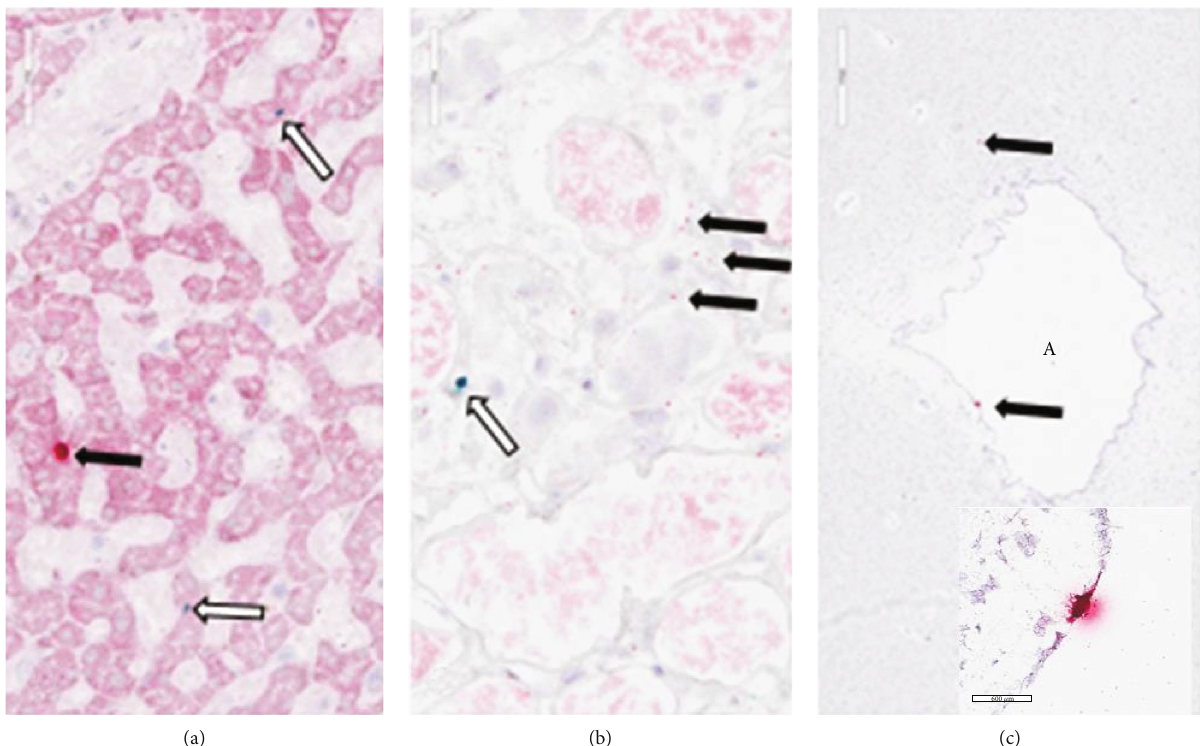
Figure 4: SARS-CoV-2 ISH of the liver (a) and kidney (b) (40x: scale bar, 60 μ m) and midbrain (c) (2x: scale bar, 600 μ m) and inset 40x (scale bar, 50 μ m). A: cerebral aqueduct. Black arrows: red signal (antisense strand RNA-replicating virus). White arrows: turquois signal (sense strand RNA-nonreplicating